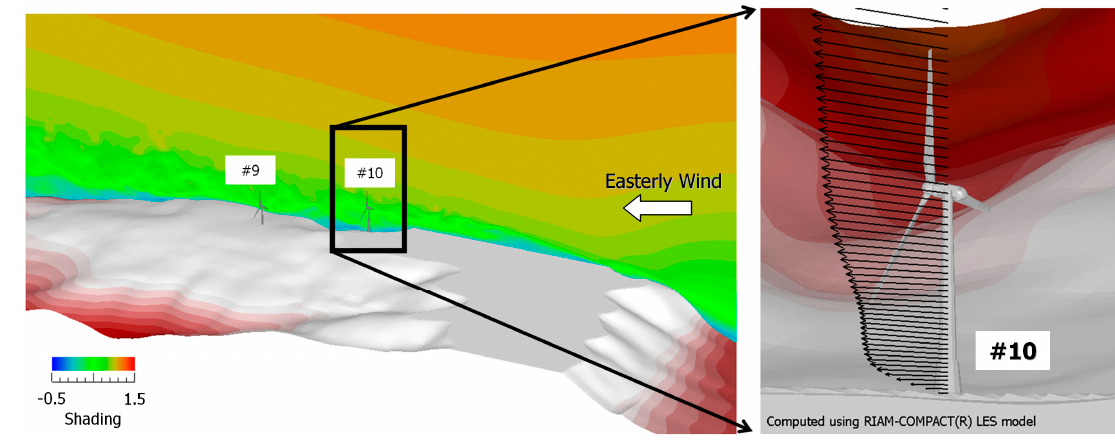
Figure 24. Distribution of the streamwise wind velocity component on a vertical cross-section, which includes wind turbine #10 and wind velocity vectors at wind turbine #10, easterly wind, and instantaneous flow field.